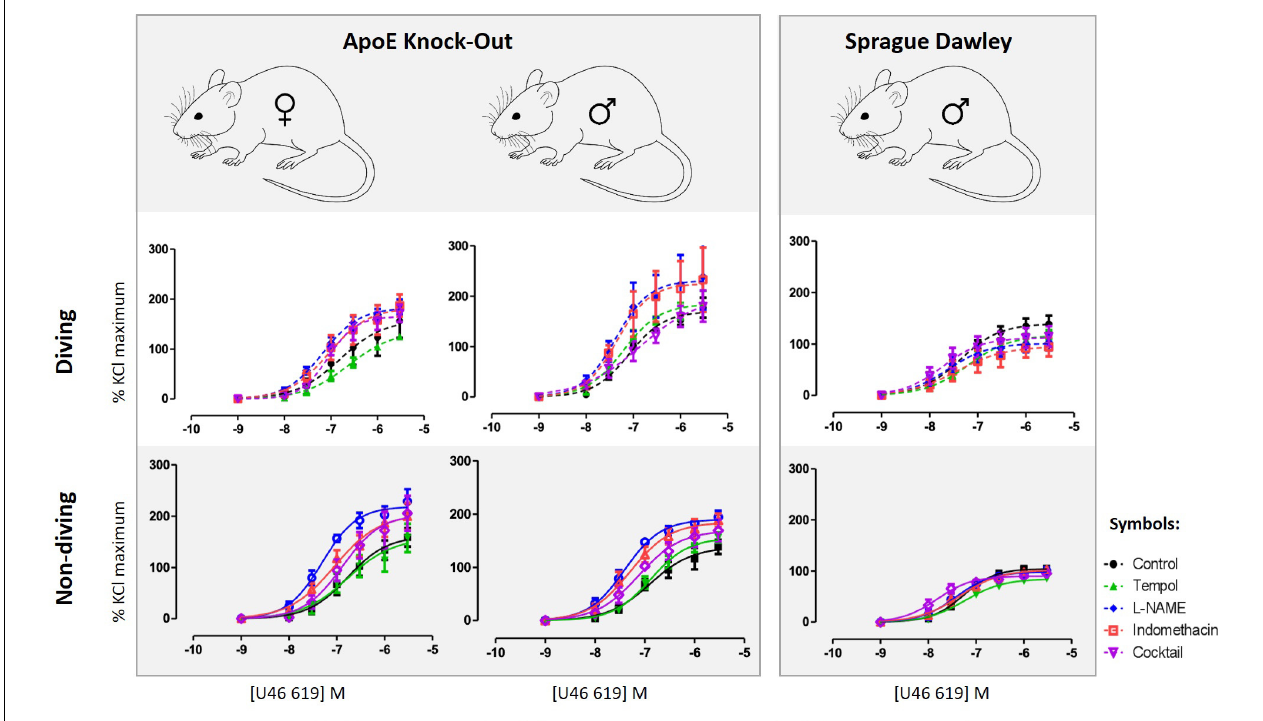
FIGURE 3 | U46619 concentration-response curves of pulmonary arteries from different experimental groups under different experimental conditions; control conditions, following 10 min treatment with superoxide scavenger, Tempol (100 µ M), incubation for 20 min with non-selective inhibitor of NO synthase, L-NAME (100 µ M), incubation for 20 min with both L-NAME (100 µ M) and indomethacin (3 µ M); (e) 20 min incubation with L-NAME, indomethacin, TRAM-34 and apamin, i.e., pharmacological inhibition of all major pathways for endothelium-dependent relaxation. F test, n = 5.